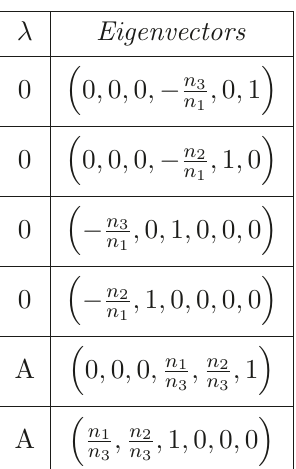
Table 1 . Eigenvectors and eigenvalues of the Hessian matrix in the critical points of the Higgs branch. The four zero eigenvalues corresponds to the real dimensions of the vacuum space, directions in which the potential is